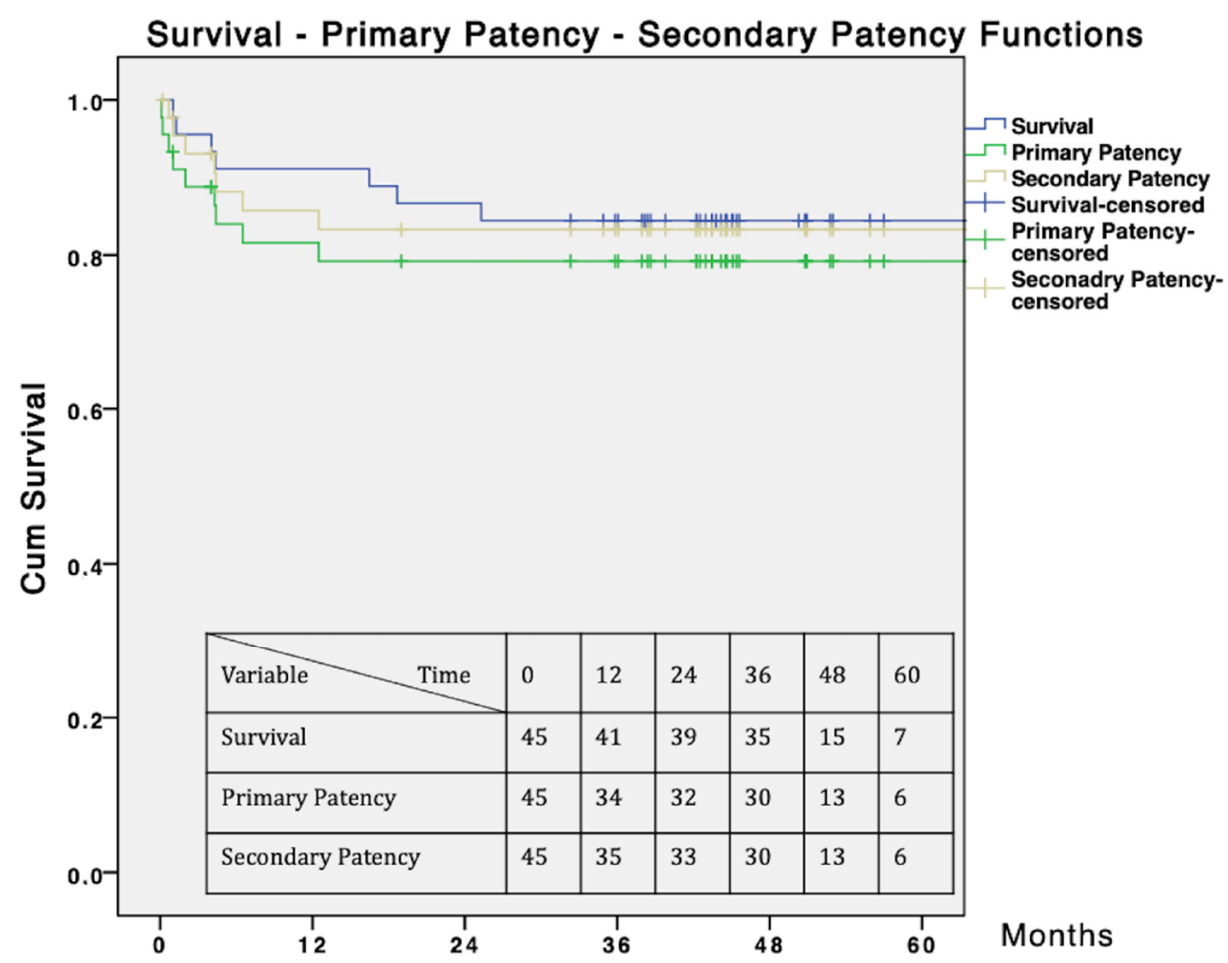
Figure 5. Survival, primary patency, and secondary patency curves. Standard error does not exceed 10% at 48 months for the survival, primary patency, and secondary patency curves.